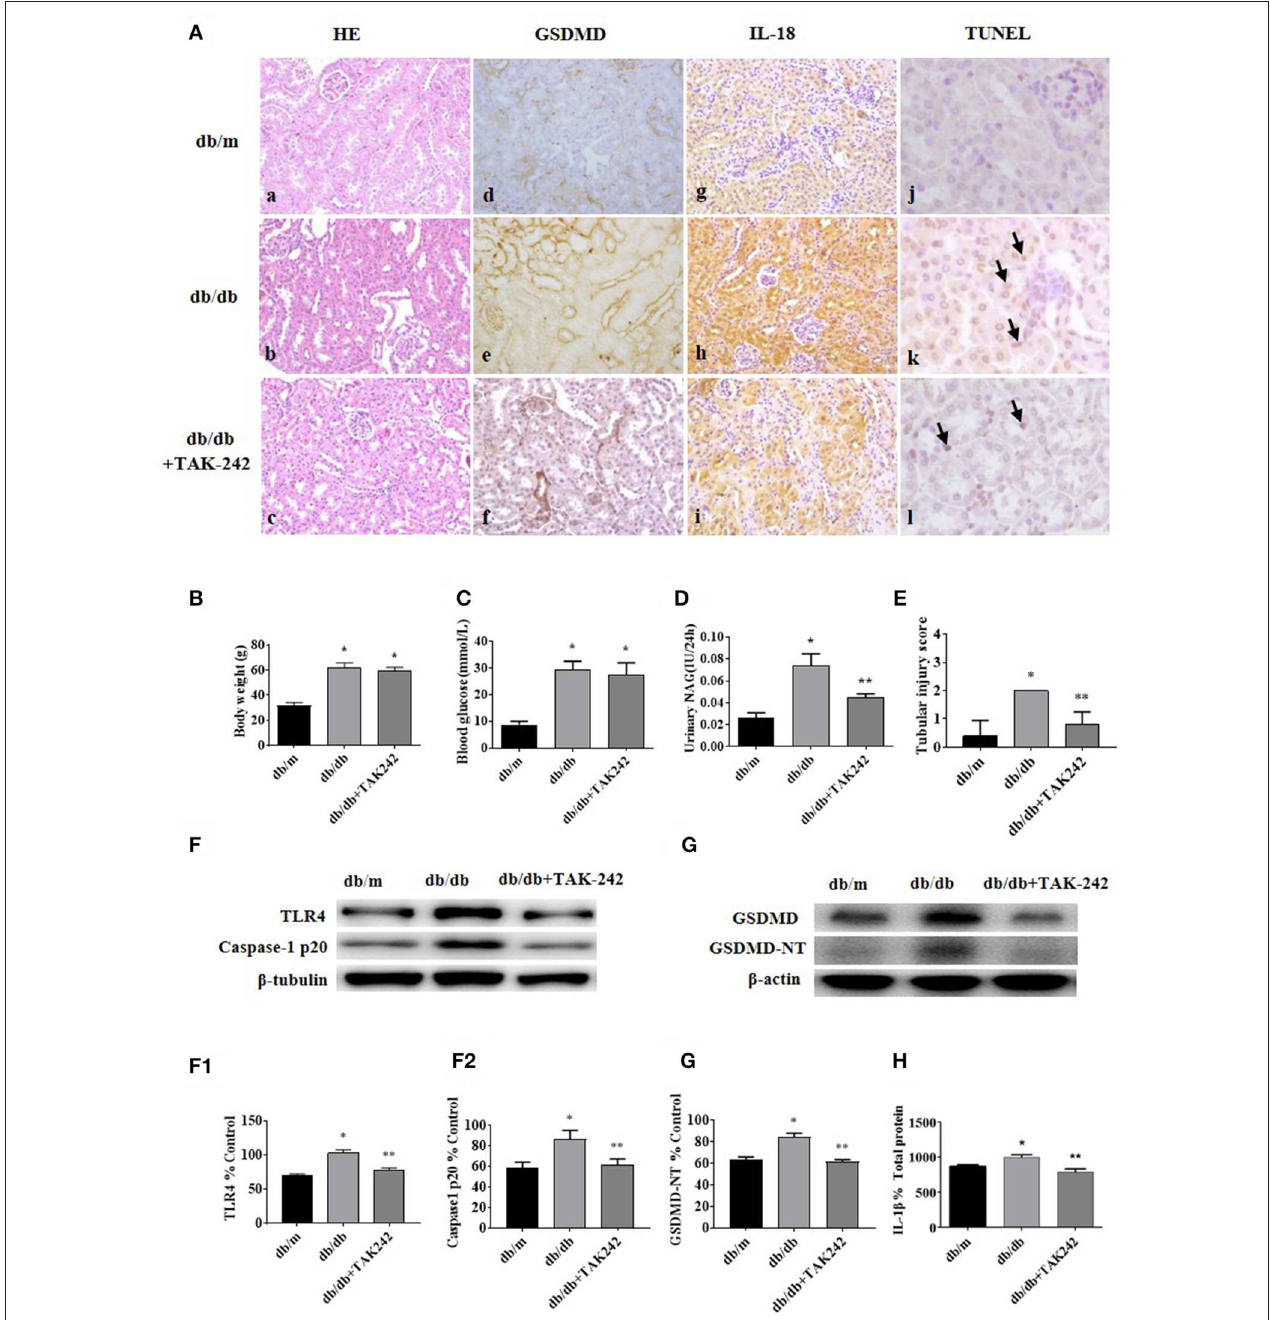
FIGURE 2 | Inhibition of TLR4 protects tubular cell injury by suppressing GSDMD-related pyroptosis in db/db mice. (A) Kidney sections stained with HE in db/m (a), db/db (b), and db/db mice treated with TLR4 inhibitor (TAK-242, 3 mg/kg) for 7 days (c); (d–f): IHC staining of GSDMD in renal tissues (magnification × 200); (g–i): representative renal cortical sections of IL-18 IHC staining (magnification × 200); (j–l): representative images of TUNEL staining (arrow show) (magnification × 400). (B) Body weight changes in different groups. (C) Blood glucose levels. (D) Urinary NAG levels. (E) Tubular injury scores. (F) Western blotting and densitometric analysis of TLR4 (F1) and caspase-1 p20 (F2) expressions in kidney tissues of db/m, db/db, and db/db mice treated with TAK-242. (G) WB and densitometric analysis (G1) of GSDMD-NT in kidney tissues in different groups. (H) IL-1 β level in kidney homogenate was measured by ELISA. Each assay was representative of three independent experiments. Data were expressed as means ± SEM. (* P < 0.05 compared with db/m group, ** P < 0.05 compared with db/db group).